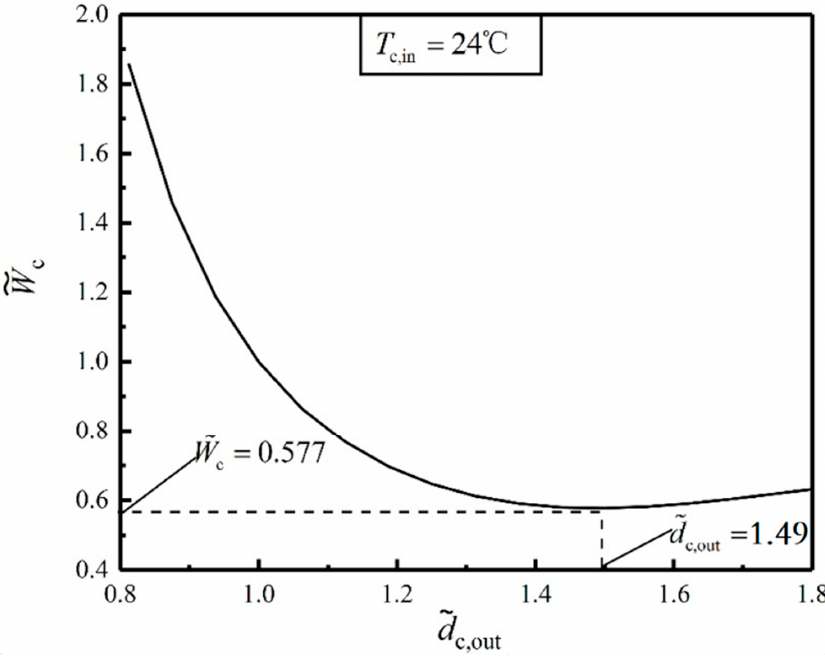
Figure 3. Relationship between (cid:101) W c and (cid:101) d c , out . Figure 4 shows the influence of the CWIT T c , in on the relationship between the dimen- sionless TPP (cid:101) W c of the condenser and dimensionless tube diameter (cid:101) d c , out . From Figure 4, one can see that for the same tube diameter (cid:101) d c , out , the dimensionless TPP (cid:101) W c of the con- denser with the CWIT T c , in = 22 ◦ C, is lower than those with the other discussed two temperatures. With the rise of CWIT T c , in , the corresponding (cid:101) W c rises gradually for the same (cid:101) d c , out . The reason is that the rise of the CWIT T c , in reduces the MTD of the condenser. To achieve the design HL of the condenser, the CW flow rate must be increased, and the increase in the flow rate causes the increases of flow resistance and TPP. In addition, the CWIT has little effect on the optimum OD corresponding to the minimum TPP, thus the optimal structure of the condenser can be stably obtained according to its design standards. Energies 2021 , 14 x